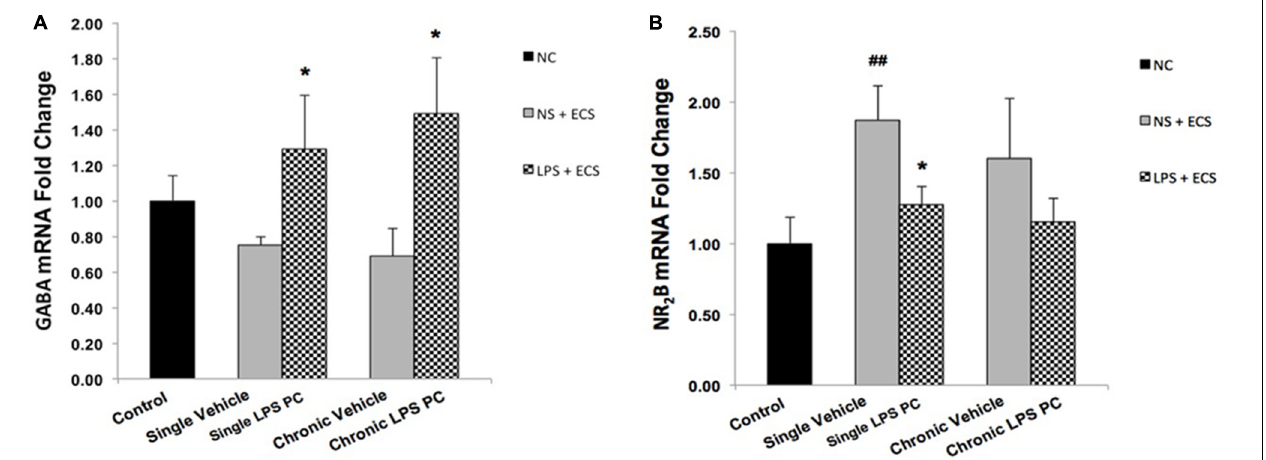
FIGURE 10 | Gene expression level of GABA A and NR 2 B in the hippocampus region of rat brain in the ECS model of epilepsy. The graphs above display the effect of preconditioning by single low dose and chronic ultra-low dose of LPS on the gene expression level of (A) GABA A and (B) NR 2 B in hippocampus in control, single preconditioned, and chronic preconditioned groups. Asterisk ( ∗ ) denotes a significant difference between the preconditioned groups and vehicle groups. Hash (#) denotes a significant difference between the vehicle groups and control groups. Statistical analysis was done according to the one-way ANOVA with significance levels of ∗ ρ < 0.05 and ## ρ < 0.01. Data are shown as mean ± SEM of three animals ( n = 3), which expressed as fold change relative to control group. ECS, electroconvulsive shock; NS, normal saline; LPS, lipopolysaccharide; PC, preconditioning; NC, no current was passed through the